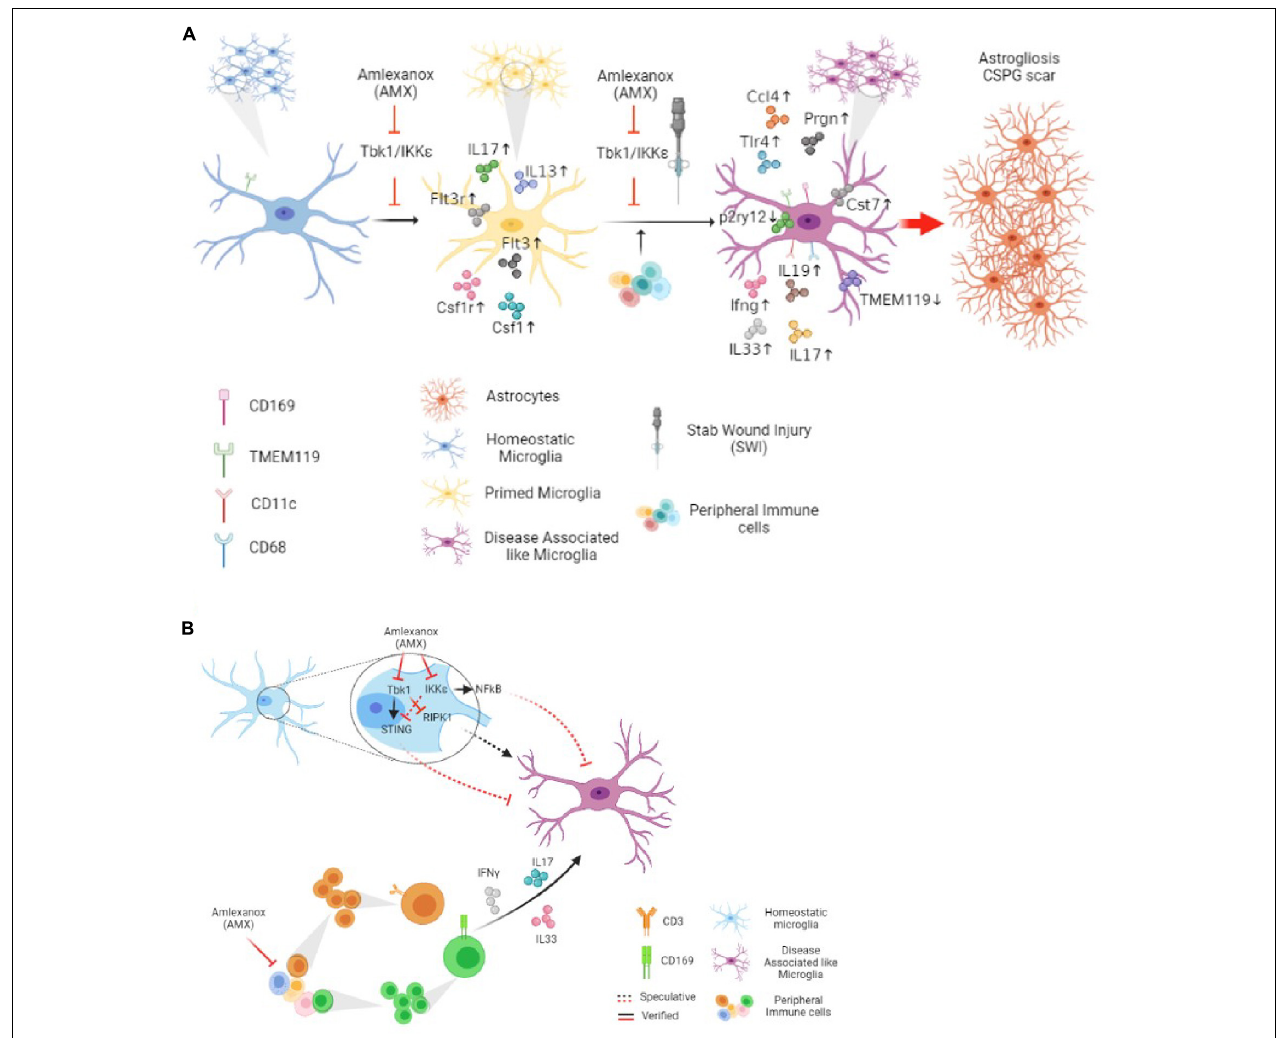
FIGURE 10 | Tbk1 inhibition by Amlexanox modifiedy the microglial and immune response in cortical Stab Wound Injury (SWI) injury. (A) Blockade of Tbk1 alone by Amlexanox (AMX), in absence of additional damage, is sufficient to increase the expression of IL-17, CSF1, CSF1R, Flt3, Flt3R, and IL-13, indicating an initial baseline pro-inflammatory state; upon SWI injury, AMX administration causes the substantial expansion of reactive microglia with immunohistochemical and expression profile similar to the Disease-Associated Microglia described in neurodegenerative conditions as well as the significant increase in the infiltration by lymphocytes and monocytes/macrophages. The ultimate effect appears to be increased astrogliosis and extensive deposition of CSPG scar. (B) At least two molecular mechanisms are proposed for AMX effect on microglial phenotype: the de-repression of the RIPK1 pathway and the de-activation of the STING pathway. The